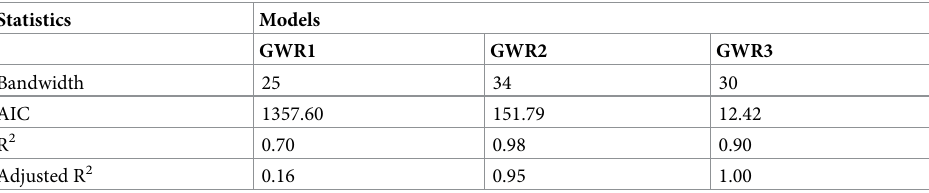
Table 4. Summary of GWR